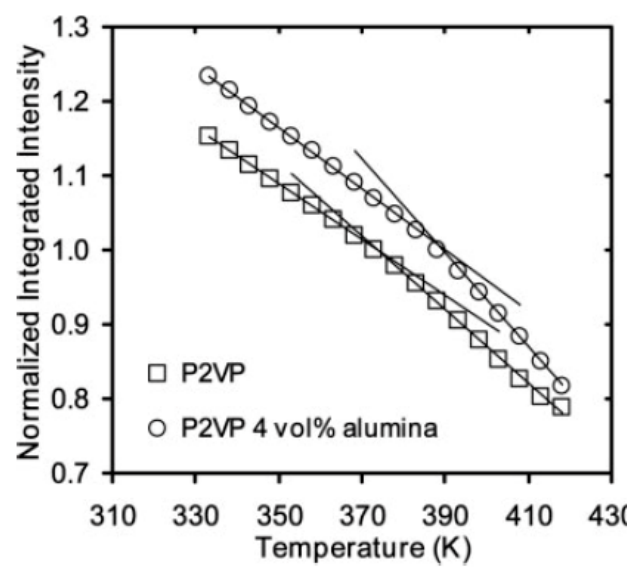
Figure 2. Temperature dependence of the normalized integrated intensity of the pyrene dopant (<0.2 wt %) in a bulk poly(2-vinyl pyridine) P2VP film and in a 4 vol·% alumina/P2VP nanocomposite film. (The integrated intensity has been normalized to one at T g ). Reprinted from reference [45] with permission from Wiley.